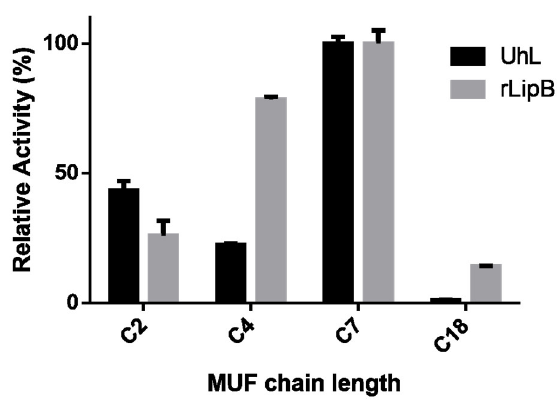
Figure 5. Relative activity of the enzymes UhL (black) and rLipB (gray) toward 4-methylumbelliferyl esters with different carbon chain lengths. The enzymatic assays were carried out at 45 °C and pH 7.0.